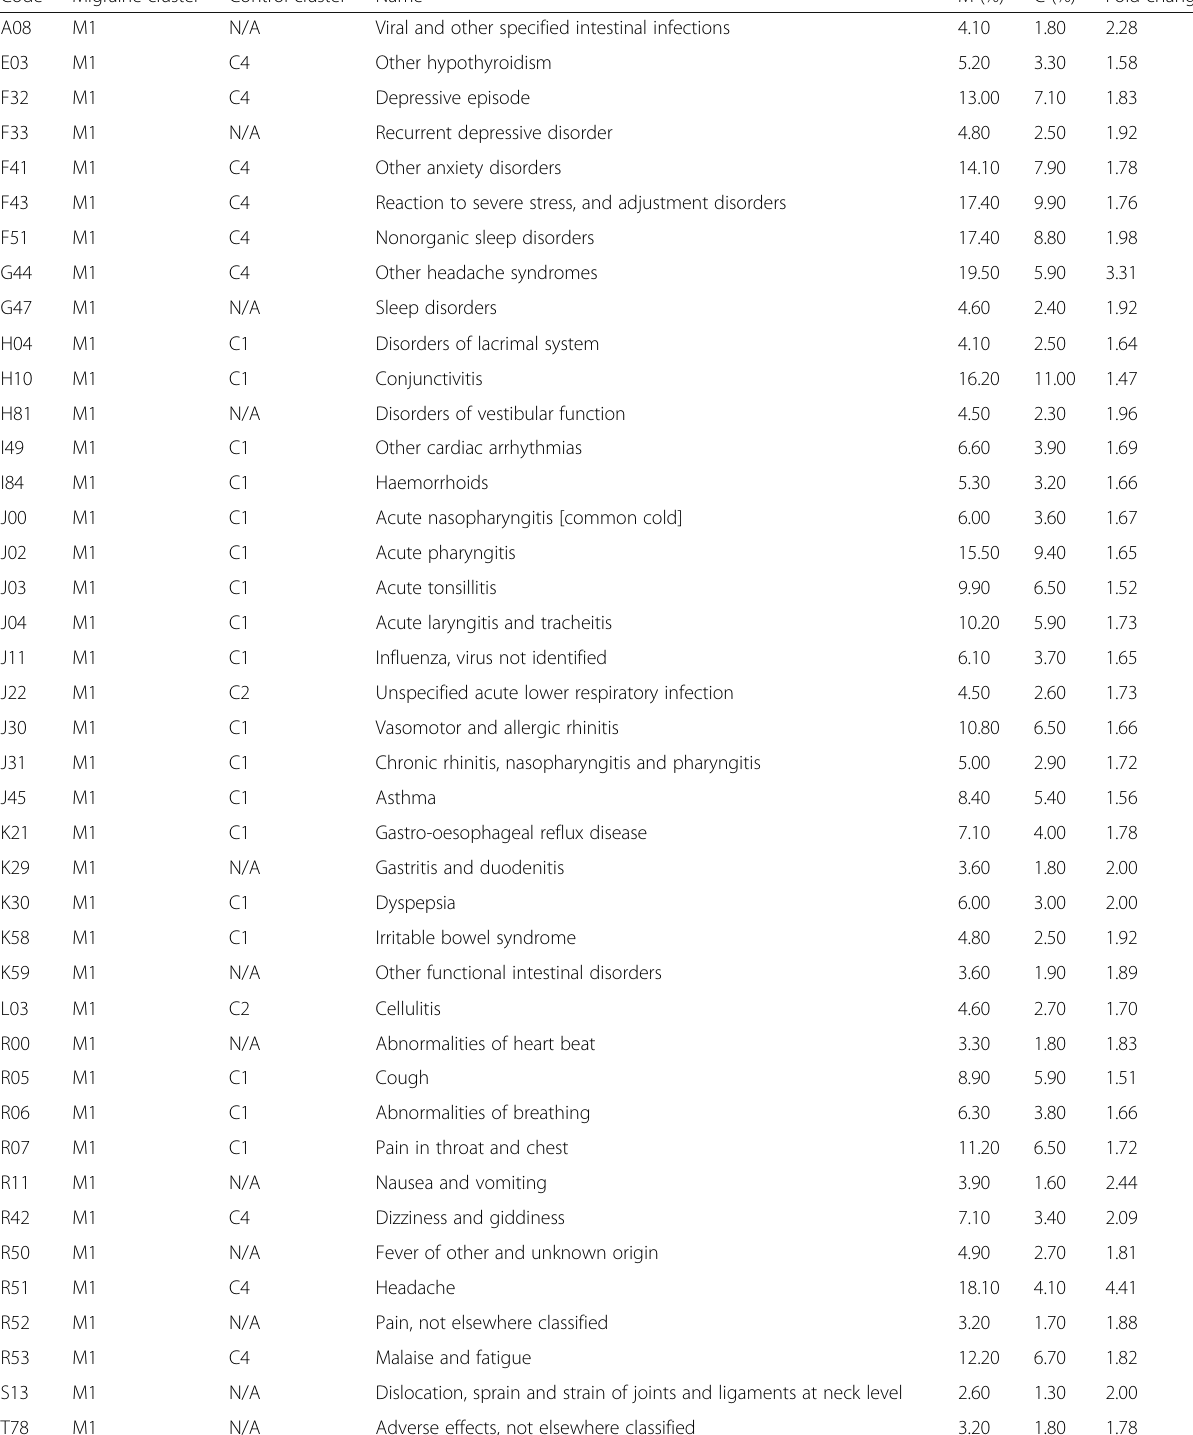
Table 2 List of diagnosis clusters from Fig. 2 sorted by their presence in migraine patients (2.5 – 20% prevalence) and compared to controls. Fold change column shows the prevalence in migraineurs divided by the prevalence in controls. All fold changes are greater than 1 indicating that migraine is associated with higher multimorbidity compared to controls. Due to high sample size, the difference in prevalence between migraineurs and controls is statistically significant ( p < 0.001) for each